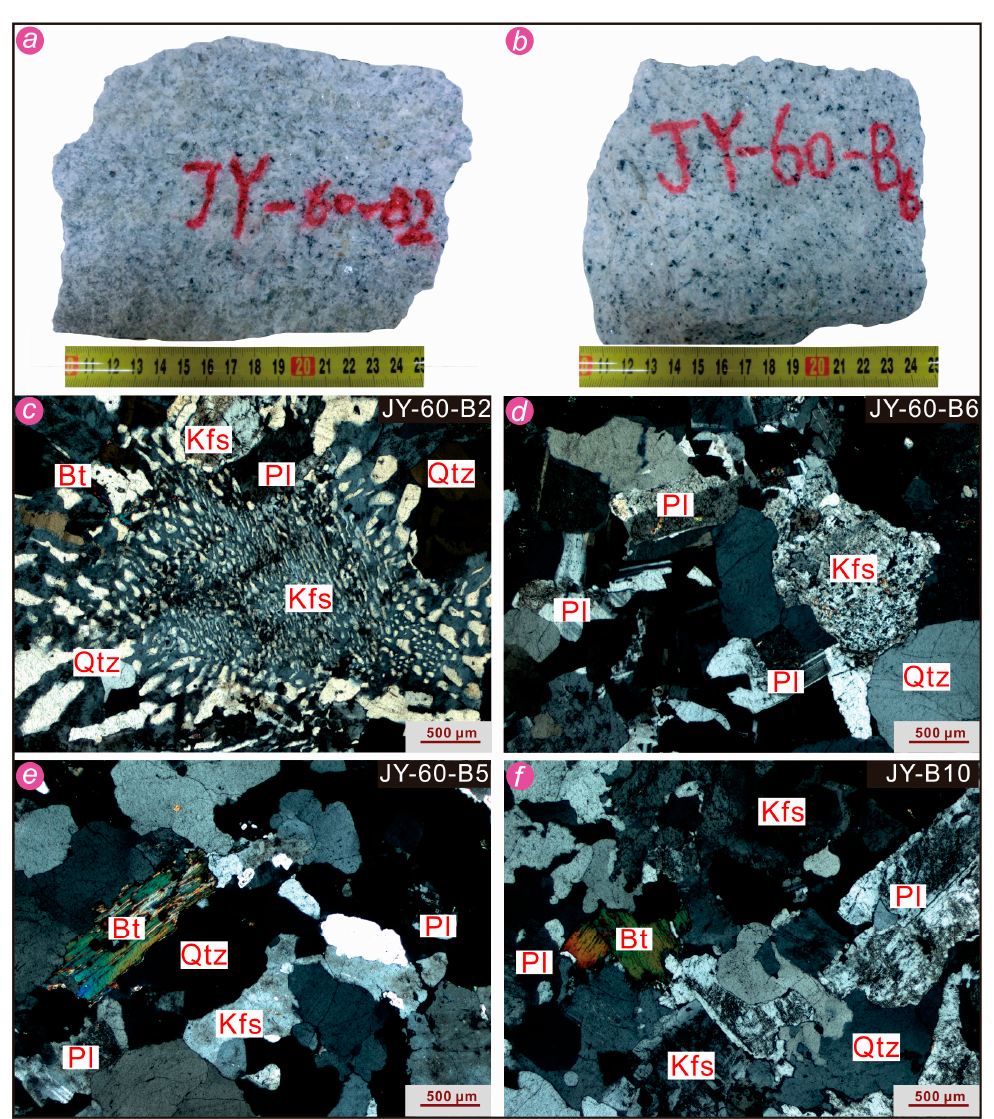
Figure 3. Photos of Junye pluton samples and microphotographs of thin sections under cross-polarized light: ( a ) and ( b ) typical biotite monzonitic granite; ( c ) graphic texture of intergrown quartz and K-feldspar; ( d ) twinned euhedral to subhedral plagioclase and slight argillization and carbonation of subhedral to anhedral K-feldspar; ( e ) and ( f ) euhedral flaky biotite and anhedral granular quartz. Abbreviations: Kfs = K-feldspar, Bt = biotite, Pl = plagioclase, Qtz = quartz.